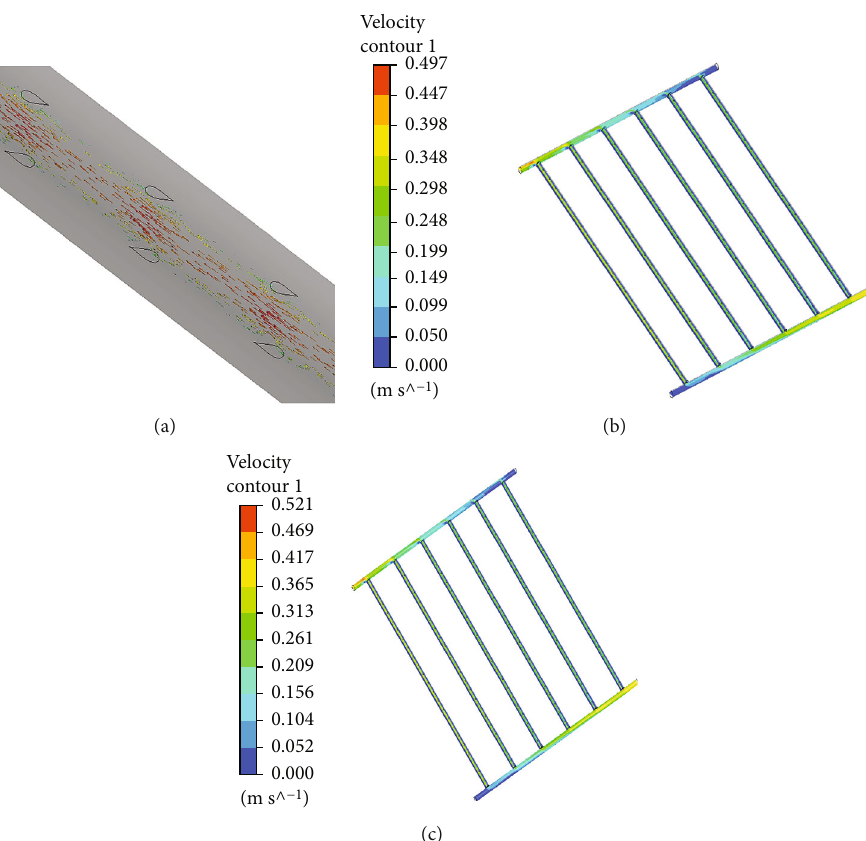
Figure 4: (a) Flow of water in dimpled tube. (b) Low velocity with low fl ow rate. (c) High velocity with high fl ow rate.